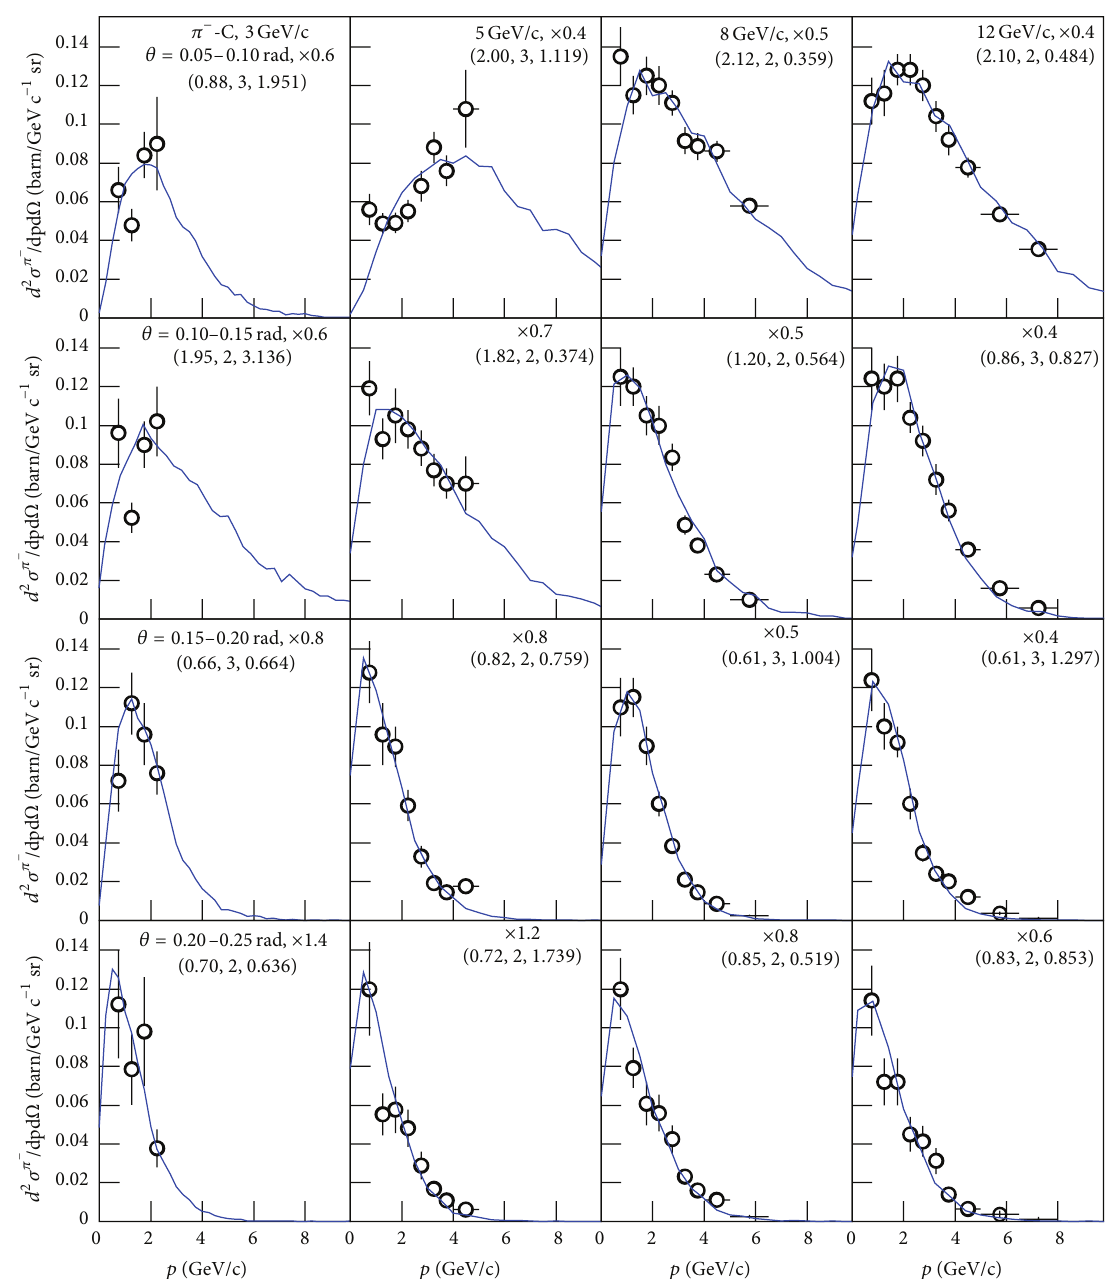
Figure 6: The same as Figure 1, but showing the results for 𝜋 − production cross sections in 𝜋 − -C